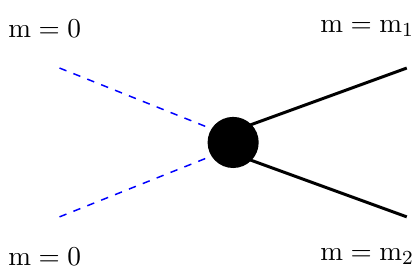
Figure 1 . The four-point amplitude involving two color singlet states. The m represents the mass of the